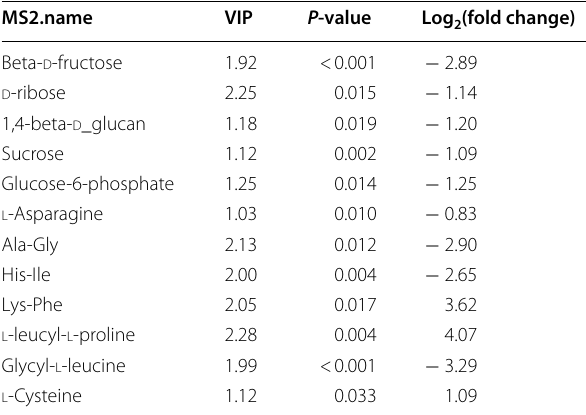
Table 4 Differential metabolites were identified in BD by mass